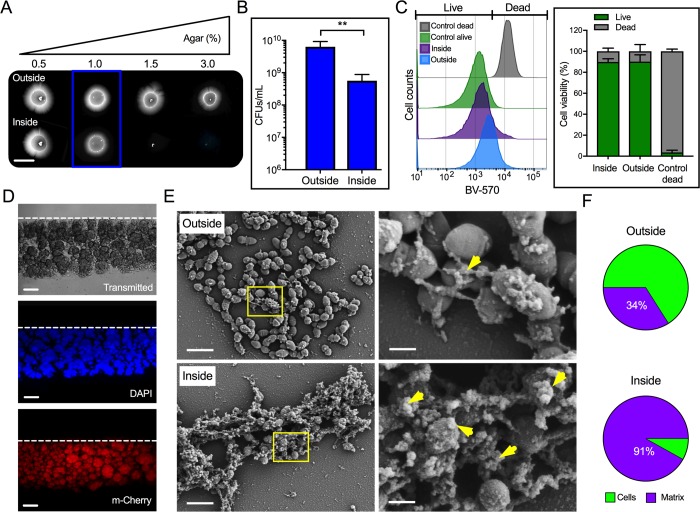
E. faecalis cells penetrating semisolid media are covered by an extracellular matrix.(A—F) The capacity of E. faecalis MMH594 to penetrate semisolid MOLP was evidenced as a colony-print inside the agar after removing external non-penetrating cells. (A) Macroscopic images of colonies (outside) and penetrating bacteria (inside) on solidified medium with the indicated agar concentrations. Scale bar: 6,000 μm. (B) Quantification of internal and external cells grown on semisolid MOLP (1% agar; blue box) expressed as CFUs/mL (mean±SE; n = 6; **P<0.01; two-tailed unpaired t–test with Mann-Whitney test). Data are representative of 5 independent experiments. (C) FACS-based viability analysis of penetrating and non-penetrating E. faecalis (right; mean±SE; n = 8). (D) Side sections of E. faecalis inside semisolid MOLP as described above. Top dashed lines indicate the beginning of the agar in each section. Lower scale bar: 60 μm. (E) SEM images of aggregated and matrix-covered (yellow arrow head) invading and non-invading cells (right panels; scale bar: 400 nm). Yellow square areas were imaged at higher magnifications (left panels; scale bar: 2 μm). (F) Fractions of cells and extracellular matrix found on the surface (~111 μm2) visible in the SEM images of penetrating and non-penetrating bacteria, as quantified using automated image analysis (mean±SE; n = 3; P < 0.05; two-tailed unpaired t–test).